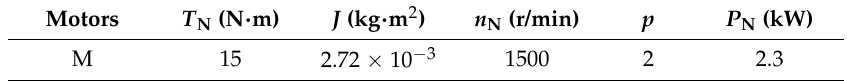
Figure 12. Experiment system: ( a ) The experimental platform for the synchronous speed control system; ( b ) System of PMSMs and the magnetic powder brake. system; ( b ) System of PMSMs and the magnetic powder brake. Table 3. Experiment parameters of permanent magnet synchronous motors